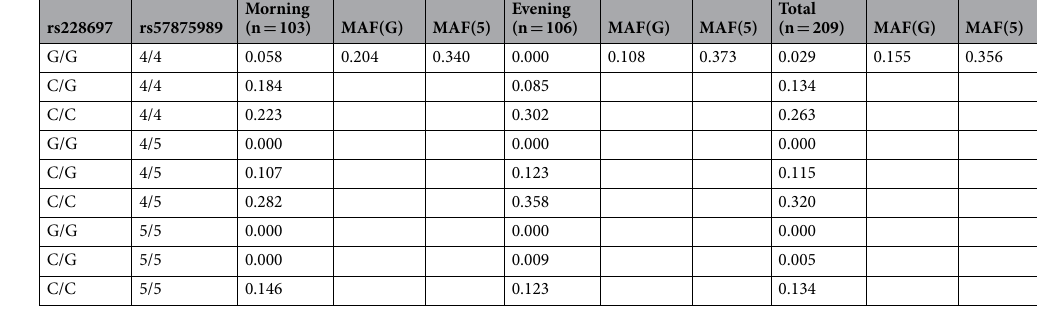
Table 2. Genotypes and minor allele frequencies at the two PER3 polymorphic sites, by diurnal preference. MAF: Minor Allele Frequency. G, C and 4, 5 refer to the alleles at rs228697 and rs57875989, respectively. The PER3 G allele (rs228697) was significantly more represented in morning types (OR = 2.10, p = 0.008). Genotypes at the two sites showed an almost complete linkage disequilibrium between the PER3 G and PER3 4 (rs57875989) alleles (D ′ = 0.912). This PER3 G - PER3 4 haplotype also showed a significant association with morningness (OR = 2.19, p = 0.016).